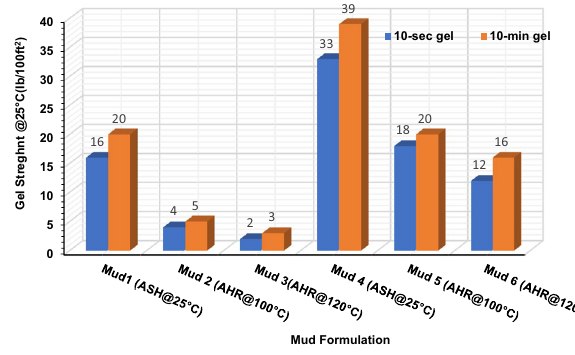
Fig. 7 Comparison of the gel strength of the drilling muds Fig. 8 API fluid losses of the mud formulations after aging at 25 °C, 100 °C, and 120